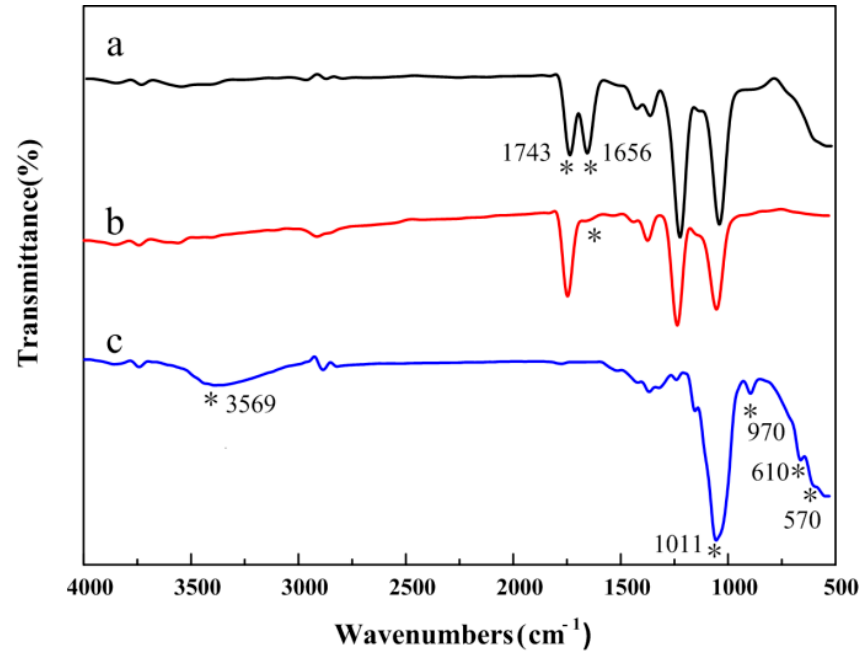
Figure 8. FTIR spectra of ( a ) CA/5% PVP fibers; ( b ) water-treated CA/5% PVP fibers; and ( c ) incubated CA/5% PVP fibers.